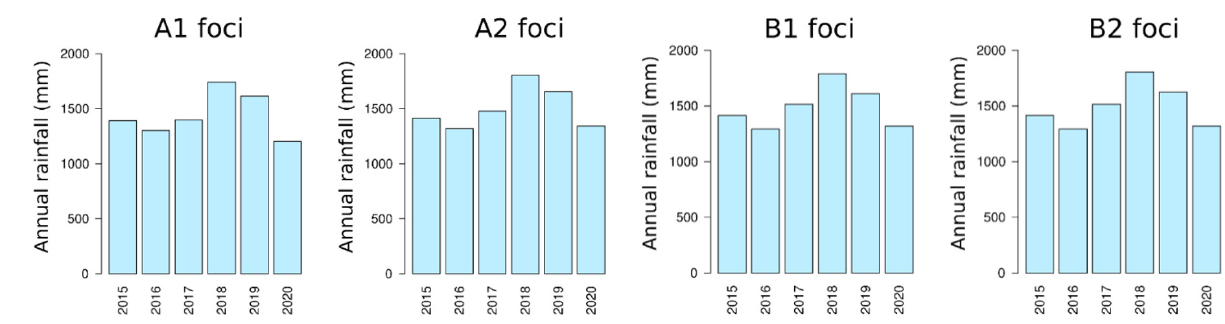
Figure A2. Median annual rainfall per foci classification, FY2015–FY2020.